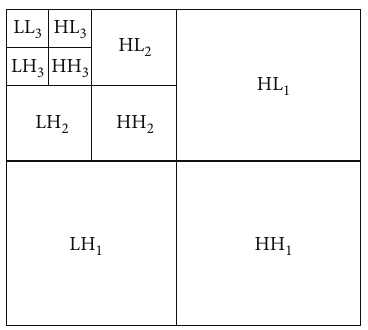
Figure 1: DWT on 2-dimensional